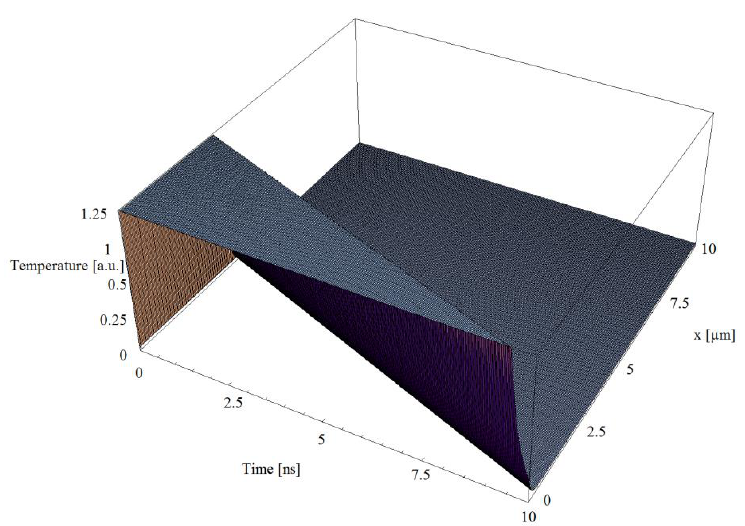
Figure 5. Spatial-temporal distribution of electron temperature density in the case of one laser pulse of 100 fs irradiation of an Ag surface for τ = 1 ps relaxation time vs. time (10 ns).